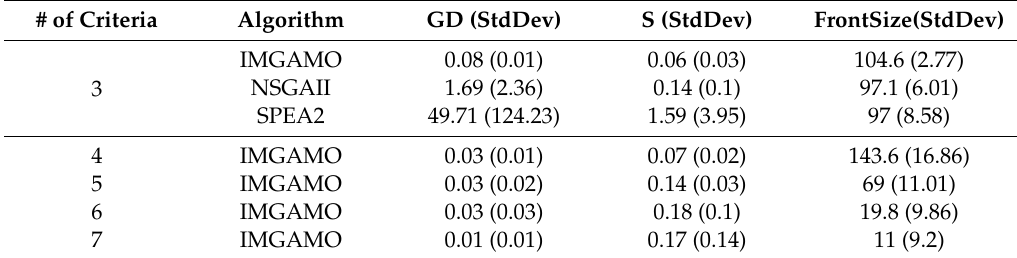
Table A6. Comparison of DTLZ3 problem